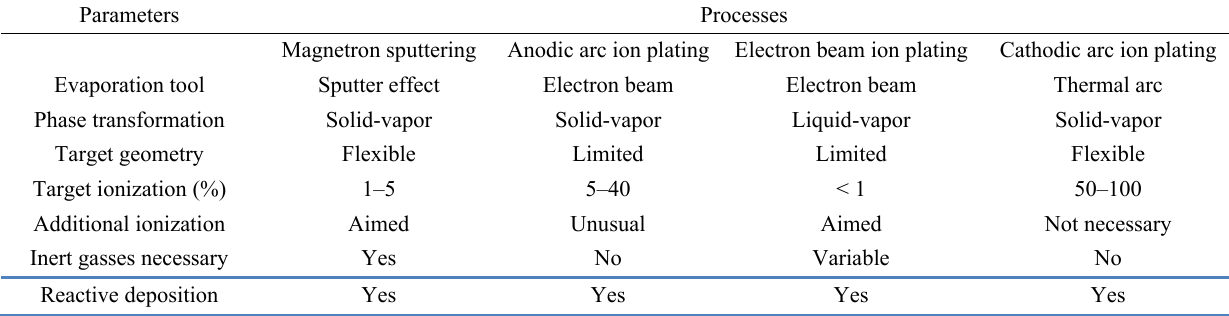
Table 1 Typical characteristics and parameters of PVD-based deposition techniques. Reprinted from Ref. [27], with permission from